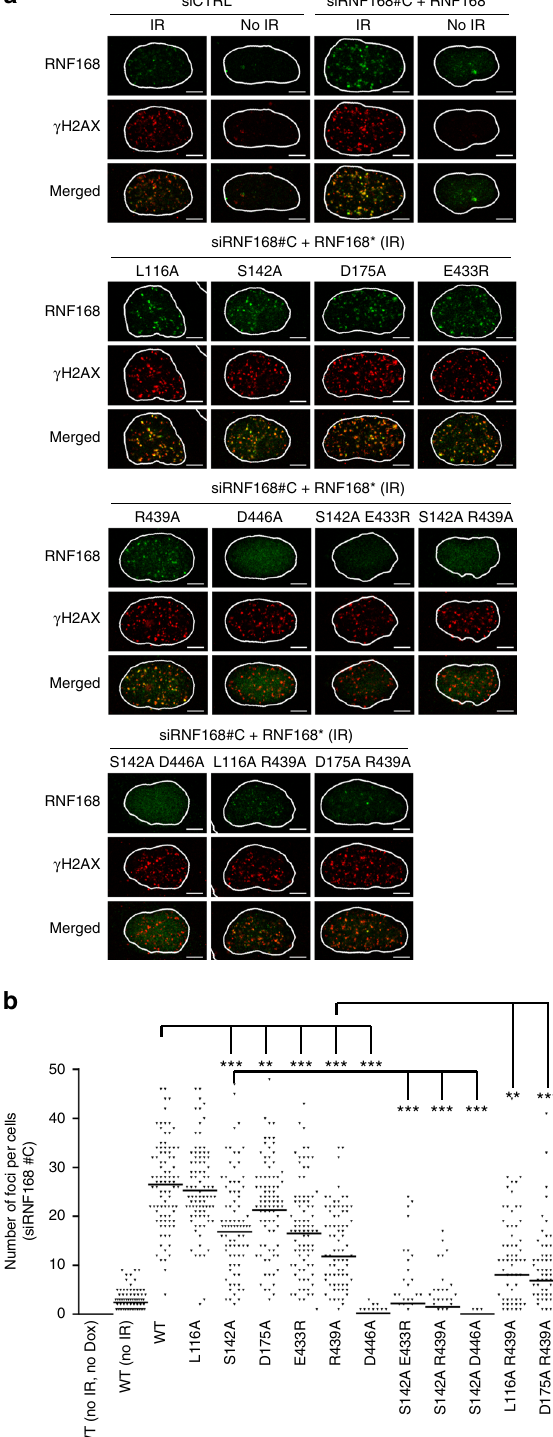
Fig. 5 Foci formation of wild-type or mutant RNF168 after gamma irradiation. U2OS cells that harbor tetracycline-inducible siRNA-resistant RNF168 were fi rst transfected with RNF168 siRNA (siRNF168#C) or non- targeting control siRNA (siCTRL). Expression of siRNA-resistant RNF168 (RNF168*) was then induced by doxycycline. The cells were irradiated (3 Gy) and processed for immunostaining using RNF168 and γ H2AX antibodies. a Representative images of immuno fl uorescence are shown. The nuclei visualized by DAPI staining were outlined with white borders. The scale bars indicate 5 µ m. Green: RNF168, Red: γ H2AX. b Quantitation of a . 90 cells were analyzed for each sample. The line represents the mean of the number of foci per cell. Signi fi cance is reported as the Kruskal –